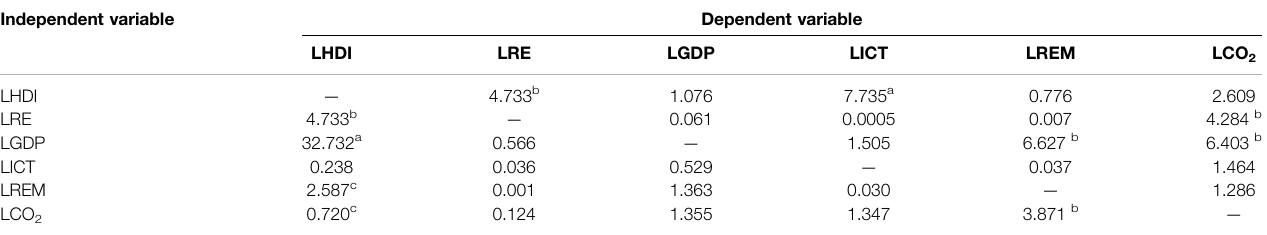
TABLE 7 | Granger causality Wald test. Independent